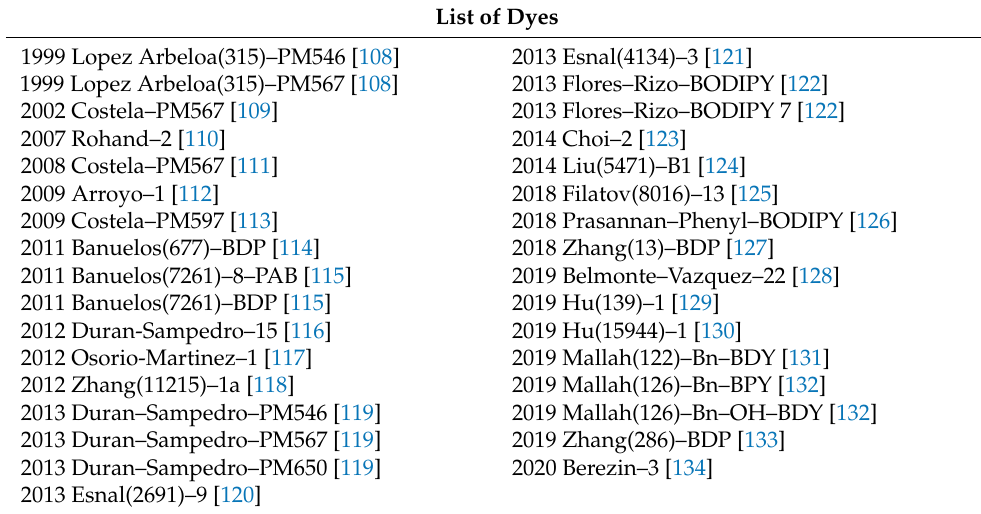
Figure 12. Solvatochromic sensitivity for duplicates of the studied dataset, solvent count ≥ 10 for the target dataset, and solvent count ≤ 9 for an extra dataset. Table 2. List of dyes selected for a comparison of the duplicates.